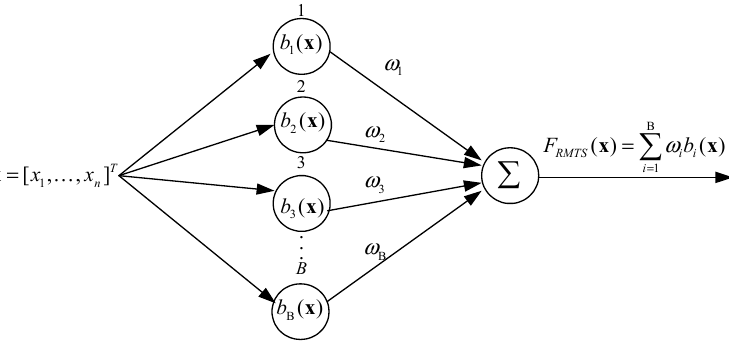
Figure 1. Structure of a regularized minimal-energy tensor-product splines.